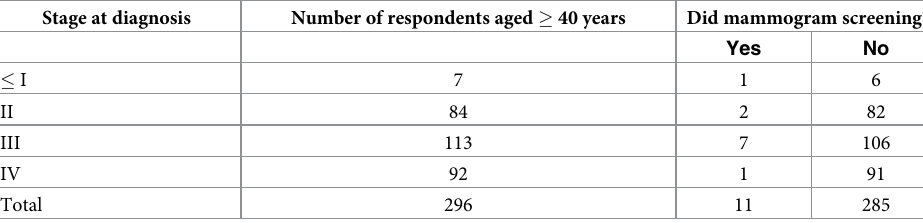
Table 3. Stage and status of mammogram screening for respondents aged (cid:21) 40 years. Stage at